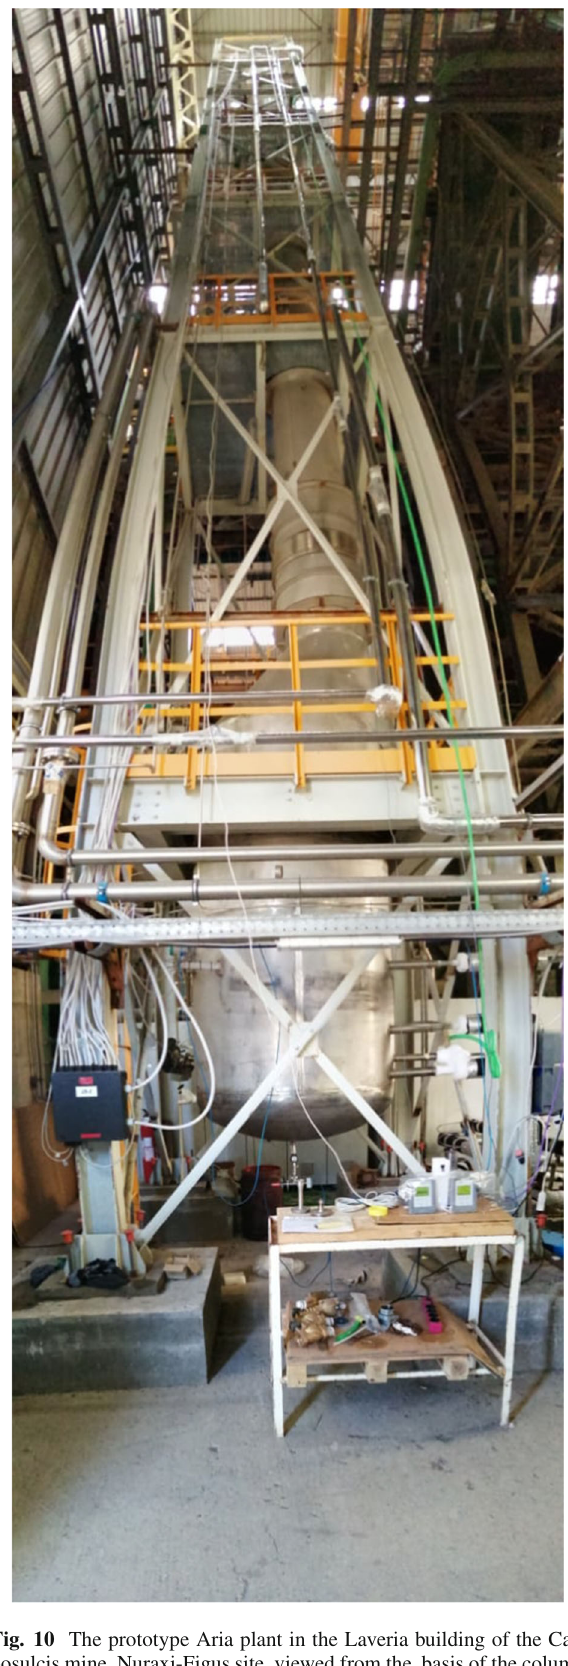
Fig. 10 The prototype Aria plant in the Laveria building of the Car- bosulcis mine, Nuraxi-Figus site, viewed from the basis of the